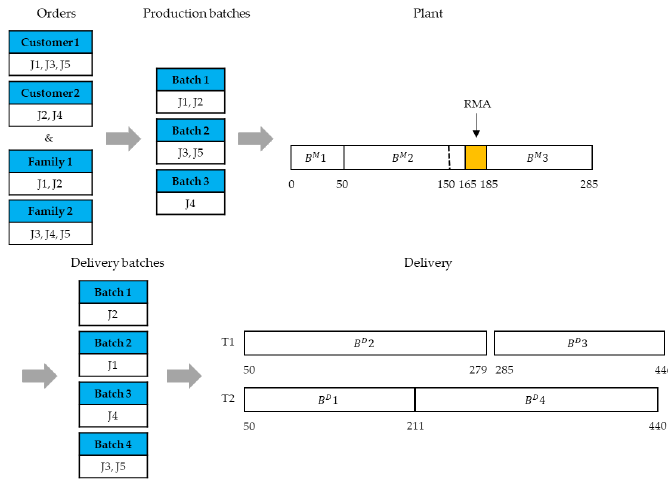
Figure 1. A Gantt chart example of schedules for the presented